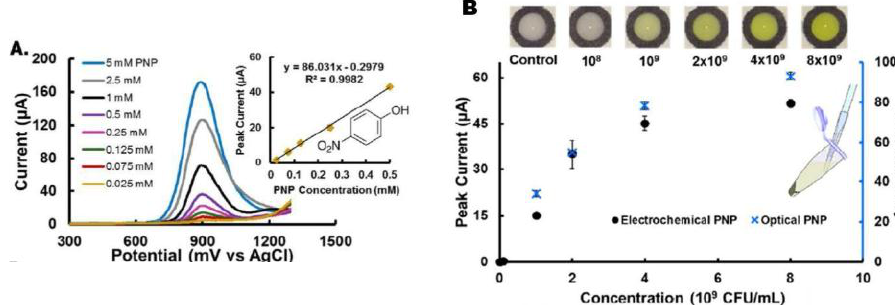
Figure 7. ( A ) SWV for increasing concentration of PAP and calibration plot in PBS buffer pH 6.5; and ( B ) electrochemical and colorimetric response of centrifuged and resuspended E. faecalis incubated for 2 h with PNP-gluco substrate. Adapted from [116] with permission from ACS.